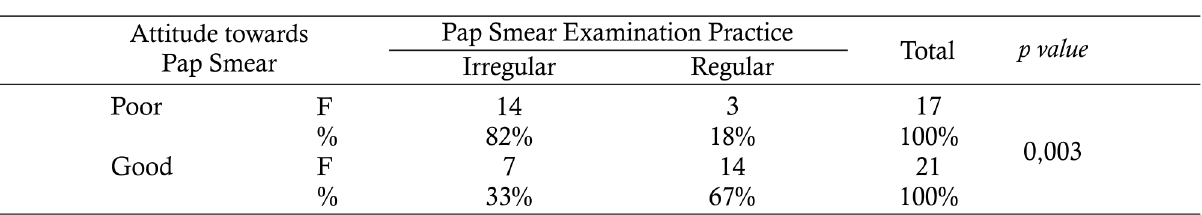
The Correlation between Medical Personnel’s Attitude and Pap Smear Examination ... Table . Correlation between Attitude towards Pap Smear and Pap Smear Examination